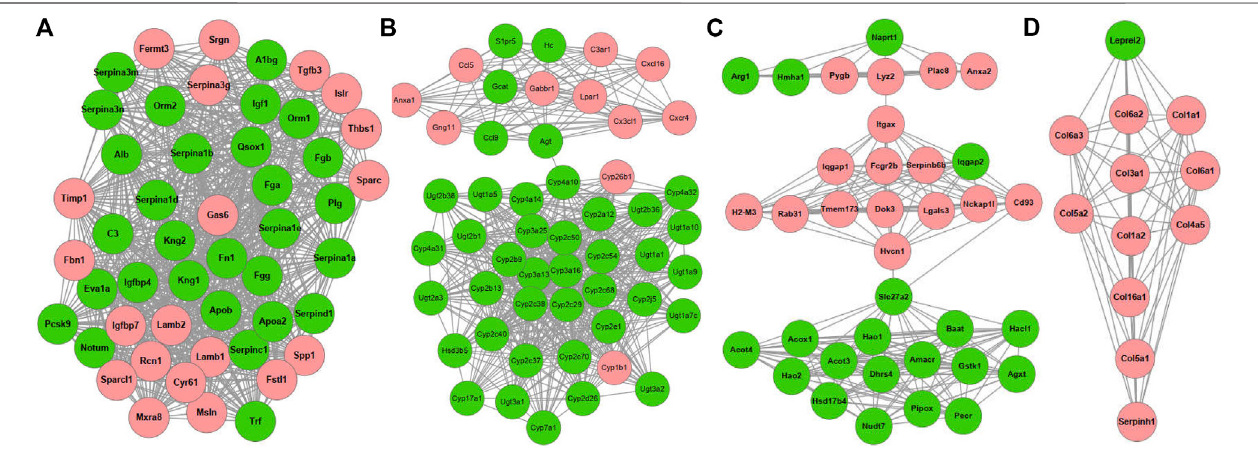
FIGURE 6 | Veri fi cation of DEGs by qRT-PCR. Expression of six genes in liver tissues was detected by qRT-PCR, and shown by the expression fold changes for Model and GDFMD vs. CN. Actb was used as the internal control.